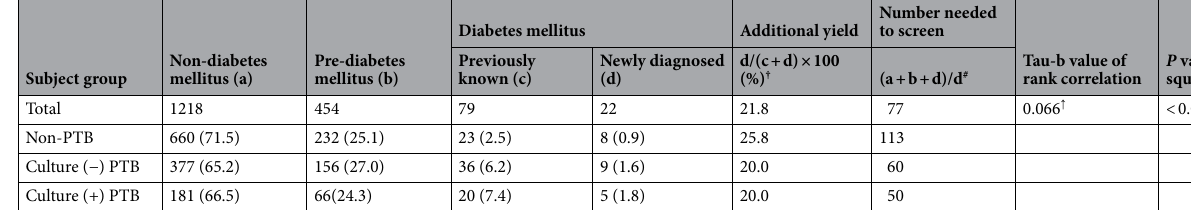
Table 2. Prevalence of DM and number needed to screen to find a new DM case among households with a tuberculosis case, 2020 (n, %). † Additional yield: the percentage of the newly diagnosed cases by screening divided by a total number of known and new cases of interested disease. # Number needed to screen (NNS): the number of people who need to be tested in to find one positive case. ↑ P value <